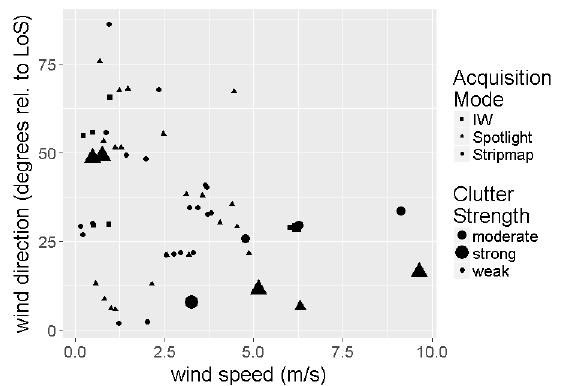
Figure 11. Wind speed (©IGB Berlin): impact on ocean clutter.